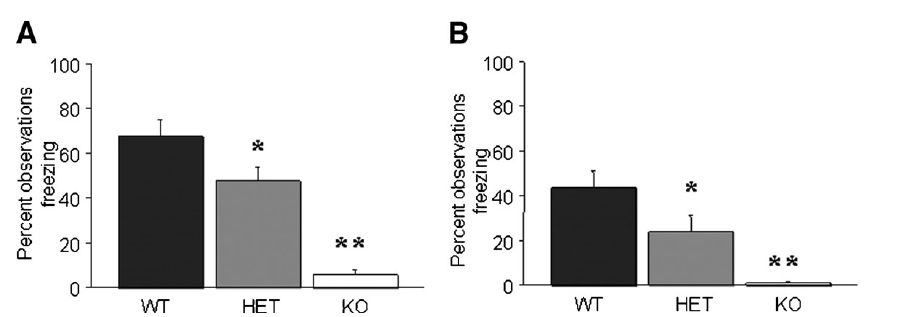
Figure 2. GluR1 KO and HET exhibit impaired one-trial delay fear conditioning. ( A ) KO and HET showed less freezing than WT during tone recall. ( B ) KO and HET showed less freezing than WT during context recall. n ¼ 10–13/genotype. Data are means (cid:3) SEM. **p < 0.01, *p < 0.05 versus WT.